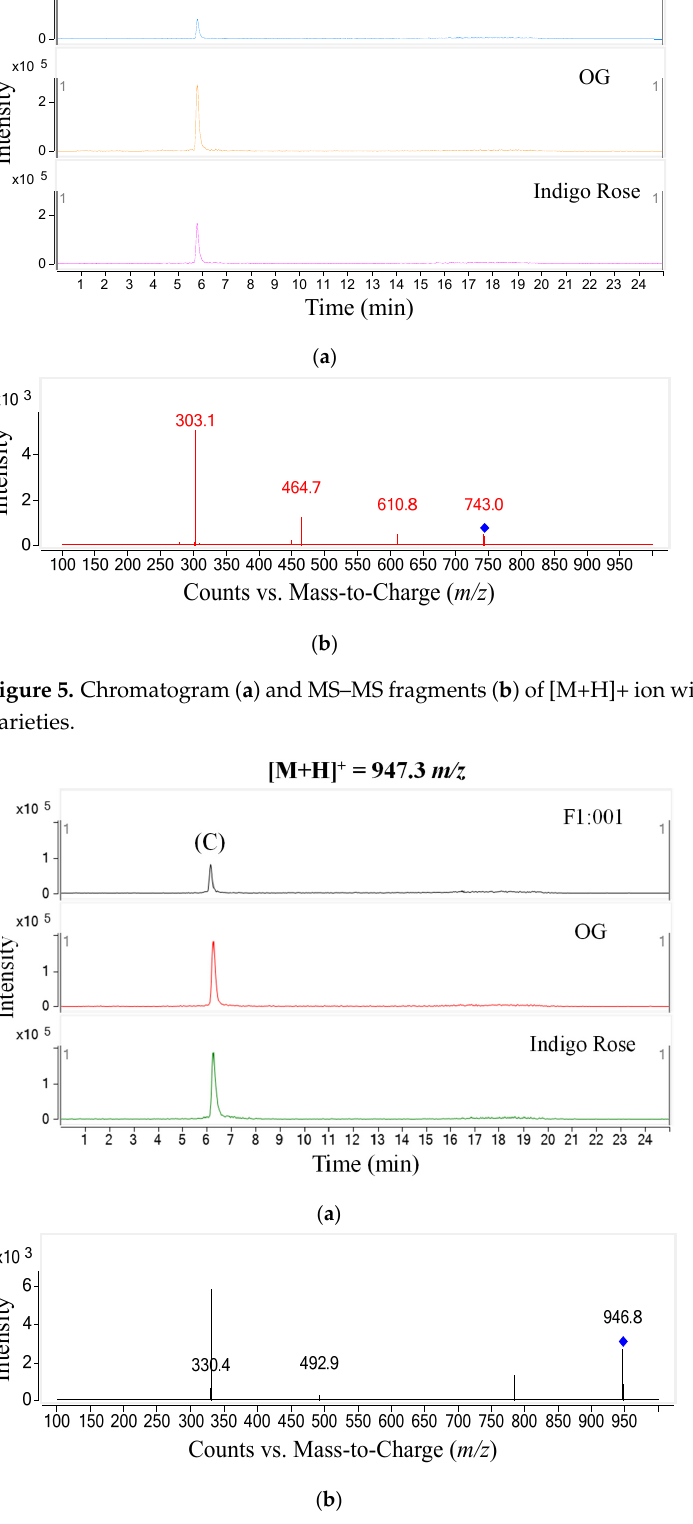
Counts vs. Mass-to-Charge ( m/z ) Figure 6. Chromatogram ( a ) and MS–MS fragments ( b ) of [M+H]+ ion with 947.3 m / z in three tomato varieties.